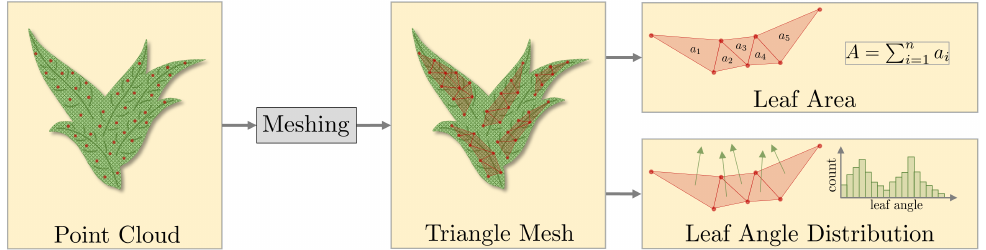
Figure 4. Extraction of leaf area and leaf inclination angle distribution by meshing our high-quality crop point clouds. We mesh the points by applying the ball pivoting algorithm and estimate the area and normal vector for each triangle generated. Finally, we sum up all triangle areas to compute the total leaf area and summarize the inclination angles in a